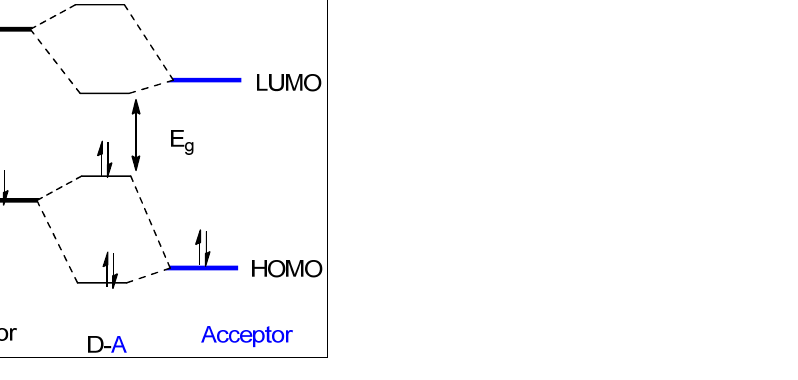
Figure 19. The energy diagram demonstrates the effect of polymerising electron-rich donor seg- ments and electron-deficient acceptor moieties on the size of the EBG